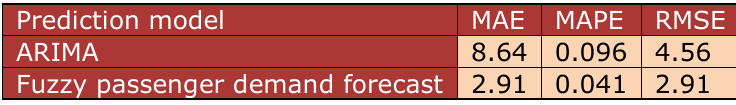
Table 3 The comparison of prediction